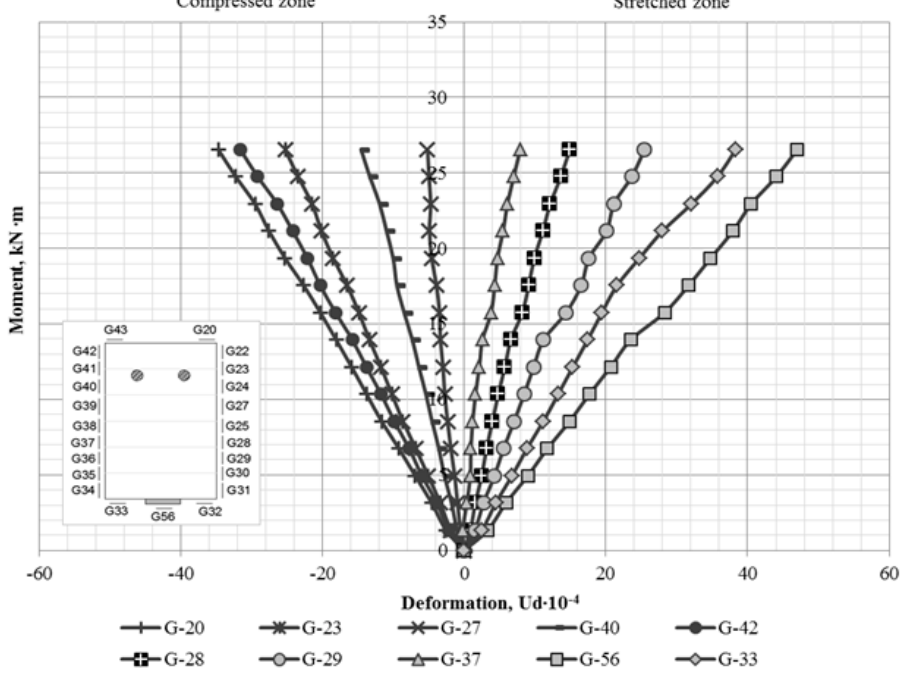
Figure 4. Graphical chart of layer deformation of cross-section fibers of GRB-12A beam in span middle.